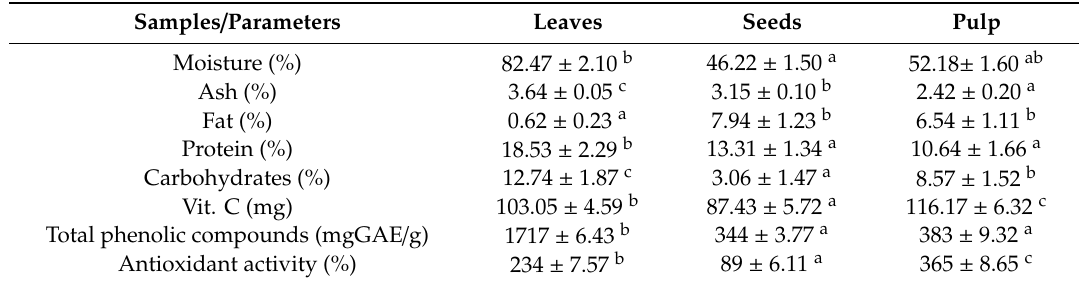
Table 1. Proximate composition and total phenolic content of guava pulp, leaves and